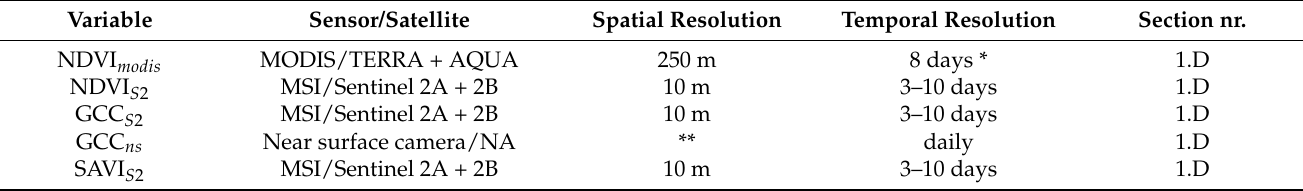
Table 3. Remote Sensing data: Variable; Sensor/Satellite, spatial resolution; temporal resolution; respective section. Please see the Supplementary Materials for more details. Variable Sensor/Satellite Spatial Resolution Temporal Resolution Section